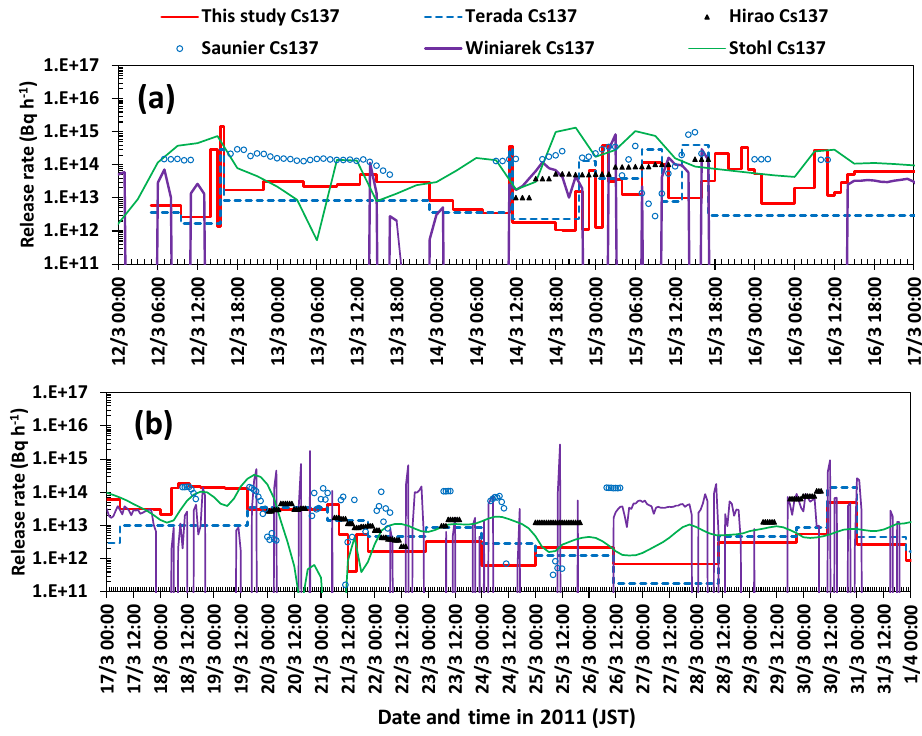
Figure 22. Comparisons of the time varying release rates for 137 Cs from 12 March to 1 April 2011 between this study and past studies (Terada et al., 2012; Stohl et al., 2012; Hirao et al., 2013; Saunier et al., 2013; Winiarek et al., 2014). Note that the values of Winiarek et al. (2014) and Stohl et al. (2012) are derived from hourly estimation results using the daily fallout, airborne survey data, and aggregated for all release layers from 0 to 1000m, respectively. It is also noted that the release rates of Saunier et al. (2013), when the plume directly flowed to the Pacific Ocean, could not be reconstructed correctly. Table 8. Total release amount of total 131 I and 137 Cs to the atmosphere from 12 March–1 May 2011 using source terms estimated from land data only (referred as “New-land”) and from both land and sea data in this study (referred as “New-landsea”) and those of past studies. Note that the values of Winiarek et al. (2014) and Stohl et al. (2012) are derived from hourly estimation results using the daily fallout, airborne survey data, and aggregated for all release layers from 0–1000m, respectively. It is also noted that the release rates of Saunier et al. (2013), when the plume directly flowed to the Pacific Ocean, could not be reconstructed